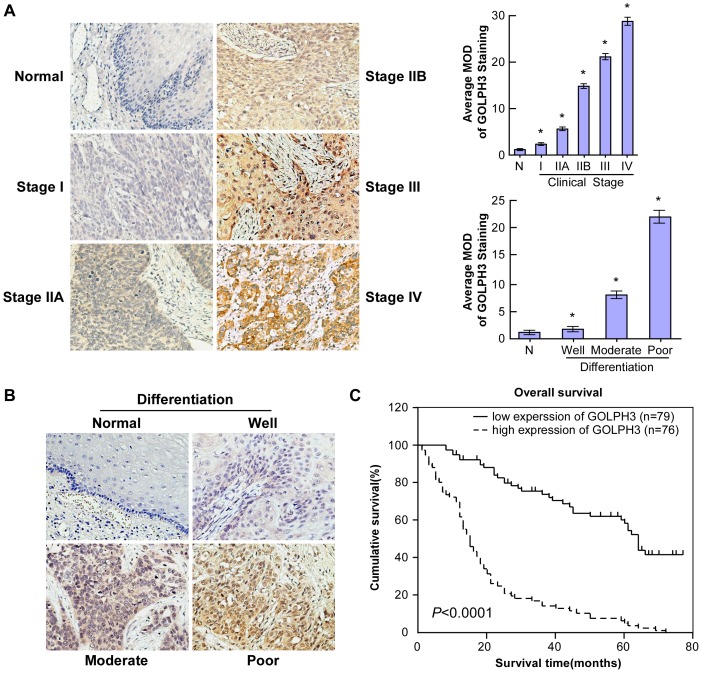
The expression level of GOLPH3 corresponded with the progression of ESCC.Average expression of GOLPH3 increased progressively from stage I to stage IV tumors, and was significantly higher than that in normal esophageal tissues (A). Moreover, GOLPH3 expression in poorly differentiated ESCC tissues was significantly higher than the expression in ESCC tissues that were moderately or well differentiated (B). Kaplan–Meier curves with univariable analyses (log-rank) for patients with low GOLPH3 expression (bold line) versus high GOLPH3 expression (dotted line) tumors (C). N, normal esophageal tissues; MOD, mean optical density.